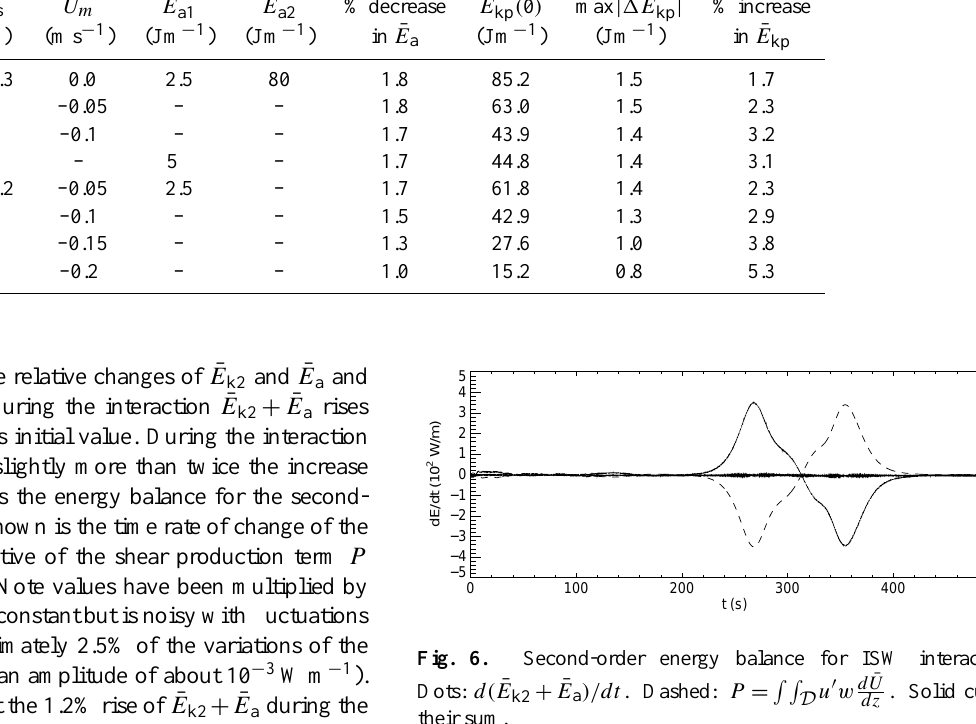
layer are at mid-depth, and the ISW is transformed into a train of ISWs of elevation riding on a broad depression ( Grimshaw et al., 1999) as depicted in Fig. 7 for a wave with initial APE of ¯ E a = 10 J m − 1